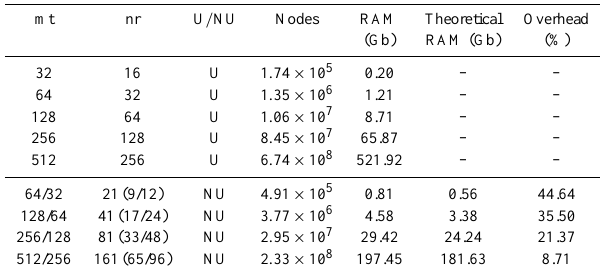
Table 3. Memory requirements for different grid configurations. Non-uniform cases incorporate refinement in the upper 750km (or ≈ 25%) of the spherical shell. Note that the theoretical RAM is calculated via the following formula, using the NU64/32 case as an example: (nodes mt64/32 / nodes mt32) ×